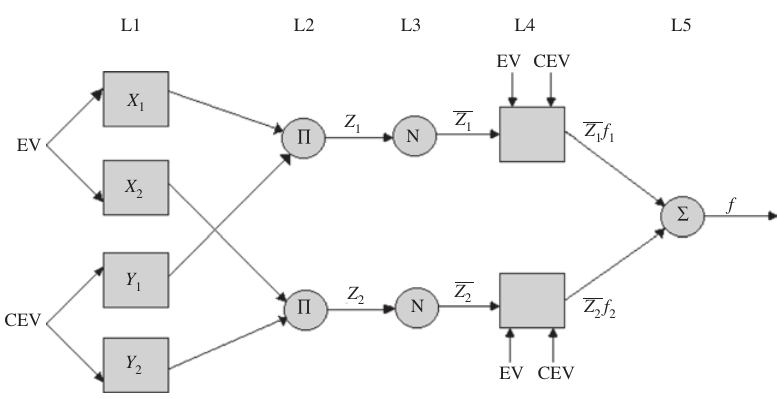
Figure 2: Structure of the Proposed